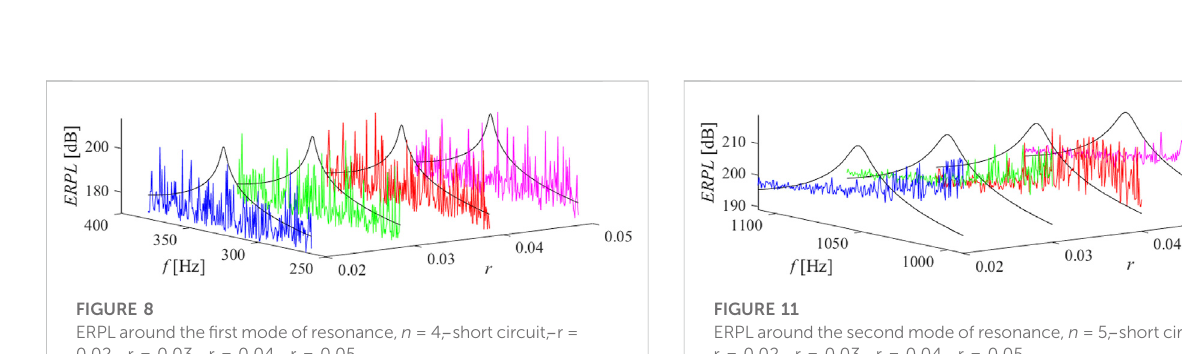
FIGURE 8 ERPLaroundthe fi rstmodeofresonance, n =4, ̶ shortcircuit, ̶ r= 0.02, ̶ r = 0.03, ̶ r = 0.04, ̶ r = 0.05.